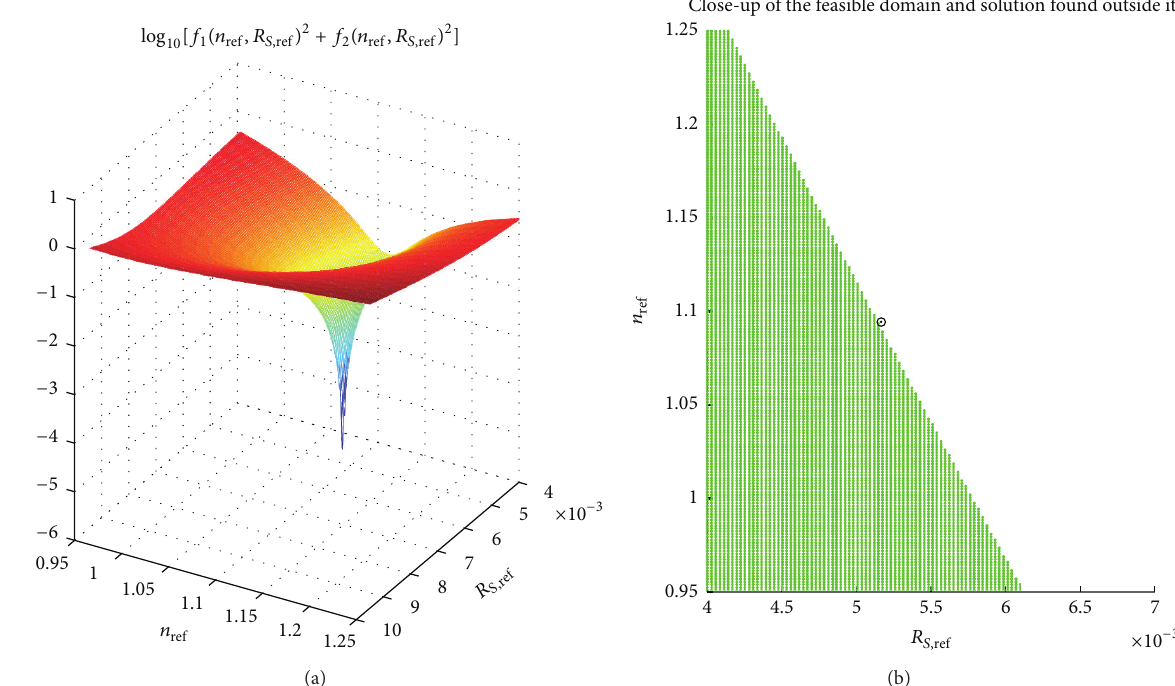
Figure 5: Graph of the functional (25) and feasible domain for the PV panel BP Q 230 panel (multi-Si technology). A unique unphysical solution exists (it lies outside the feasible domain); that is, this panel cannot be modelled by using the five-parameter